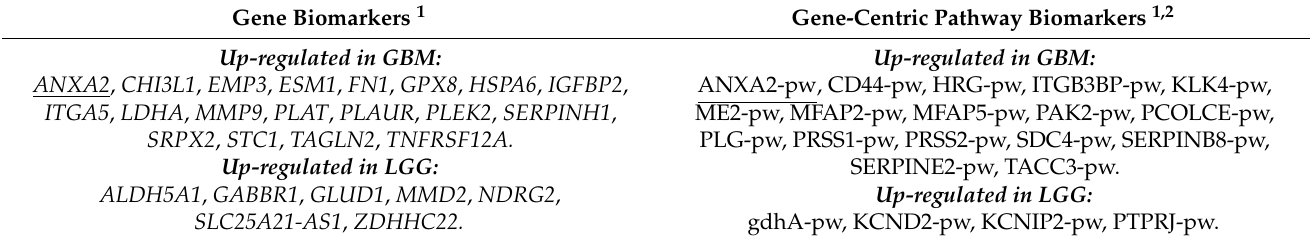
Table 1. Best individual gene and gene-centric pathway expression biomarkers identified in the GBM–LGG